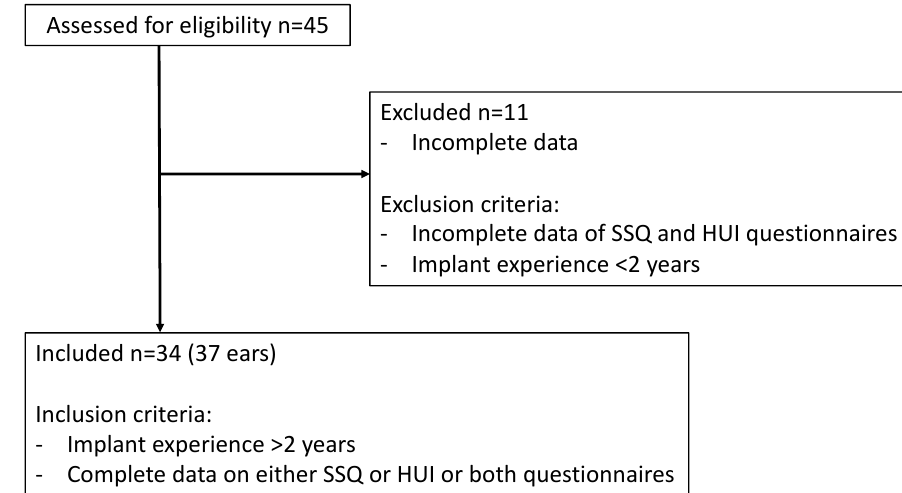
Figure 1. Inclusion and exclusion criteria.